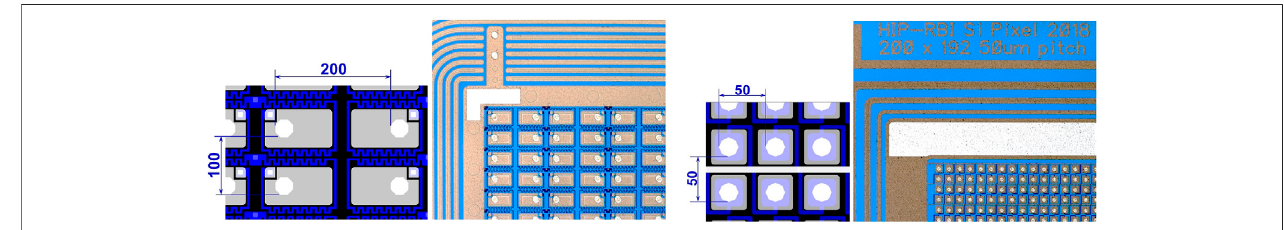
Frontiers in Physics |